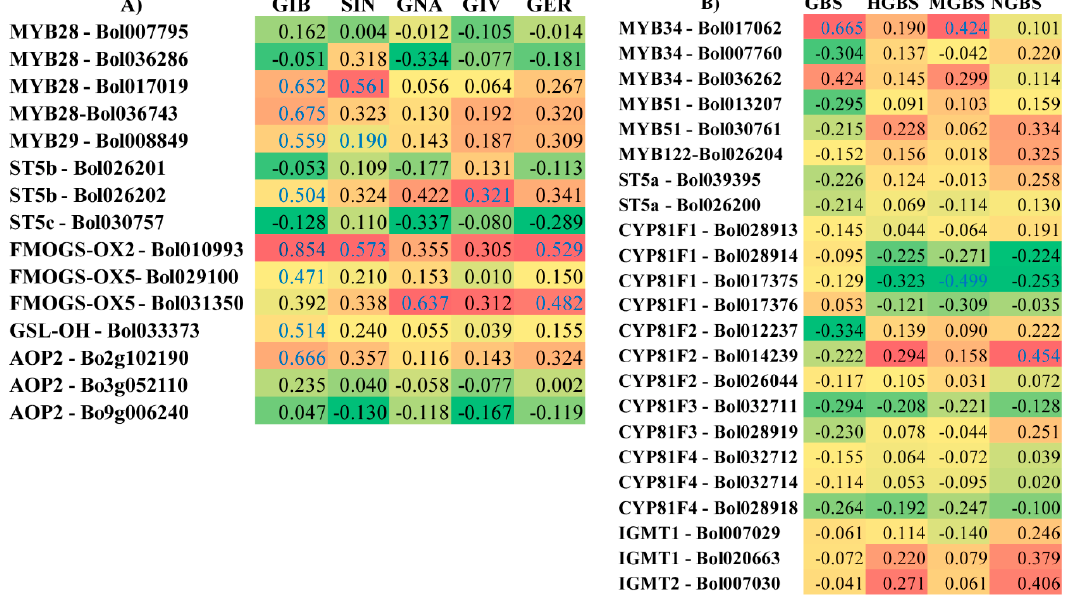
Figure 5. Heat maps showing correlation between the levels of aliphatic ( A ) and indolic ( B ) glucosinolate component and expression of biosynthesis genes under four specific treatments (M-d1: Mock day 1; T-d1: Treated day 1; M-d14: Mock day 14; T-d14: Treated day 14) in Ringspot R line BN4072 and S line BN3449 of cabbage. Blue letters represent statistically significant correlation ( p < 0.05). For each gene and glucosinolate combination, the values indicate Pearson correlation coefficient. Red cells represent positive correlation, and green cells represent negative correlation. GIB: Glucoiberin; SIN: sinigrin; GNA: gluconapin, GIV: glucoiberverin; GER: glucoerucin; GBS: glucobrassicin; NGBS: neoglucobrassicin; MGBS: methoxyglucobrassicin; and HGBS: hydroxyglucobrassicin. R: Resistant; S: Susceptible.